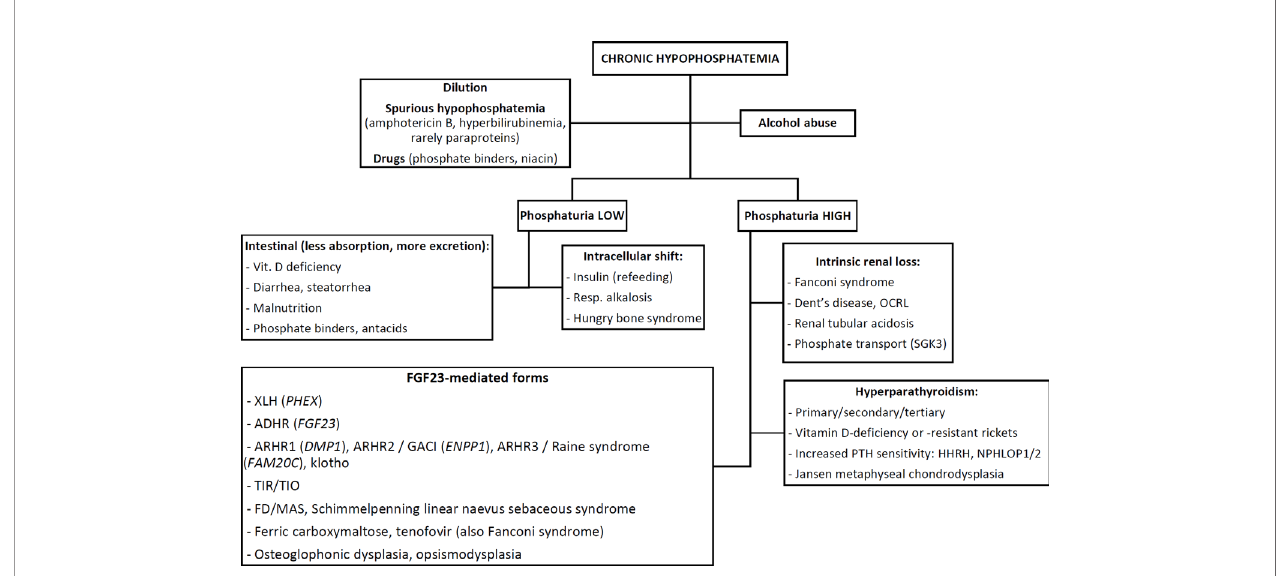
FIGURE 1 | Flowchart outlining the differential-diagnosis of chronic hypophosphatemia based on biochemical features. See text for abbreviations.